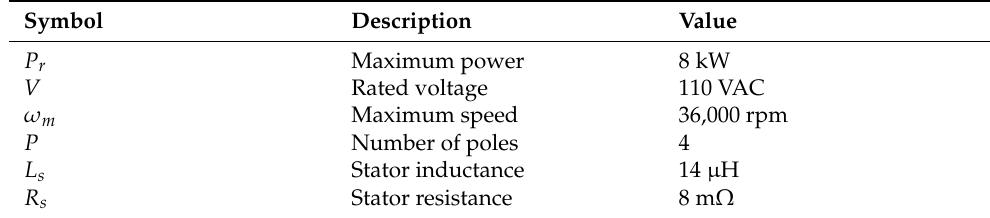
Table 2. The main specifications of the PMSM.